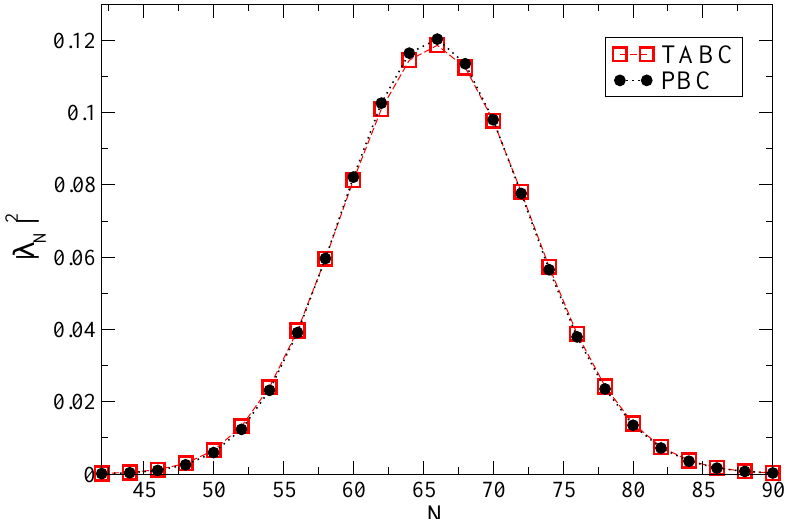
Figure 4. The probability of finding a PBCS ground state with N particles projected out of a Bardeen– Cooper–Schrieffer (BCS) ground state with (cid:104) N (cid:105) = 66